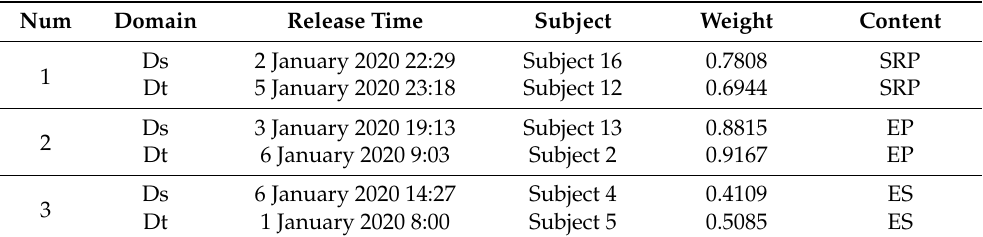
Table 1. Examples of the texts of the same topic in D s and D t (T1 time slice). Num